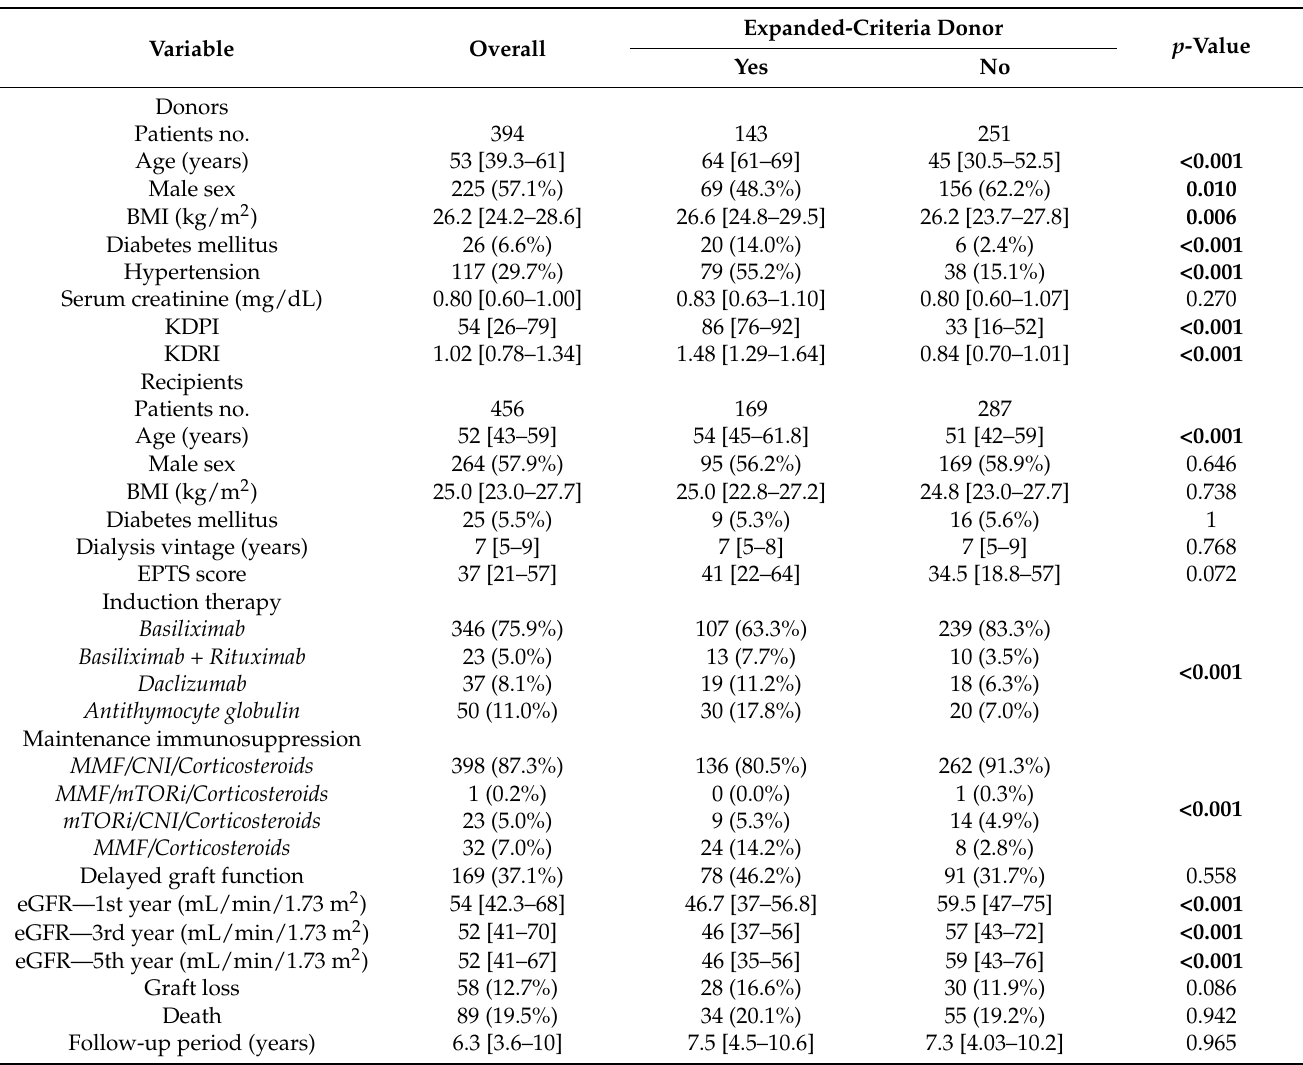
Table 1. Baseline patients’